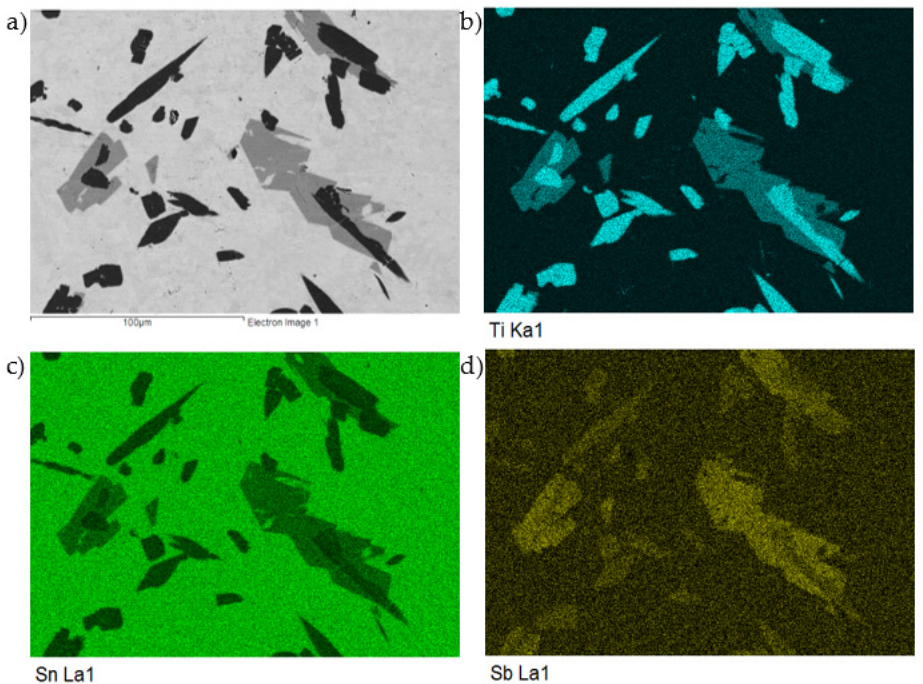
Figure 14. The map of Ti, Sn, and Sb elements in the microstructure of the SnSb5Ti3 solder. SEM photo of ( a ) the microstructure, ( b ) Ti, ( c ) Sn, and ( d ) Sb.